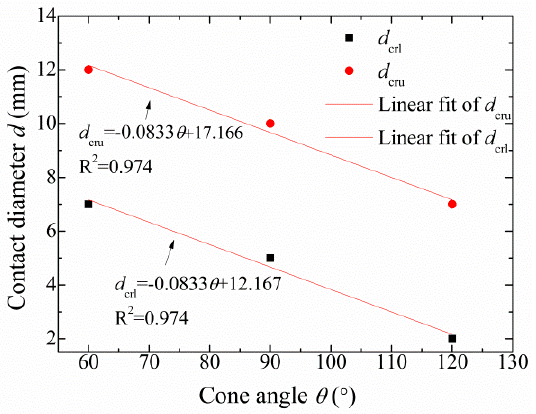
Figure 15. Relationship between critical normal diameter d cr and cone angle θ . For the same cone angle, particle shape is the same for the same ratio of contact diameter d to sphere diameter D . As the breakage mode is related to particle shape instead of particle scale [33], ratios of the critical contact diameters d crl and d cru to sphere diameter D for particles of the same cone angle should be constants. For the particles of cone angle of 90 ◦ , when sphere diameters are 30 mm, 50 mm and 70 mm, the ratios of the lower critical contact diameter d crl to sphere diameter D are 0.10, 0.10 and 0.11, the ratios of the upper critical contact diameter d cru to sphere diameter D are 0.23, 0.20 and 0.23, respectively. Then the relationship between critical contact diameters d crl and d cru and sphere diameter D can be described as: